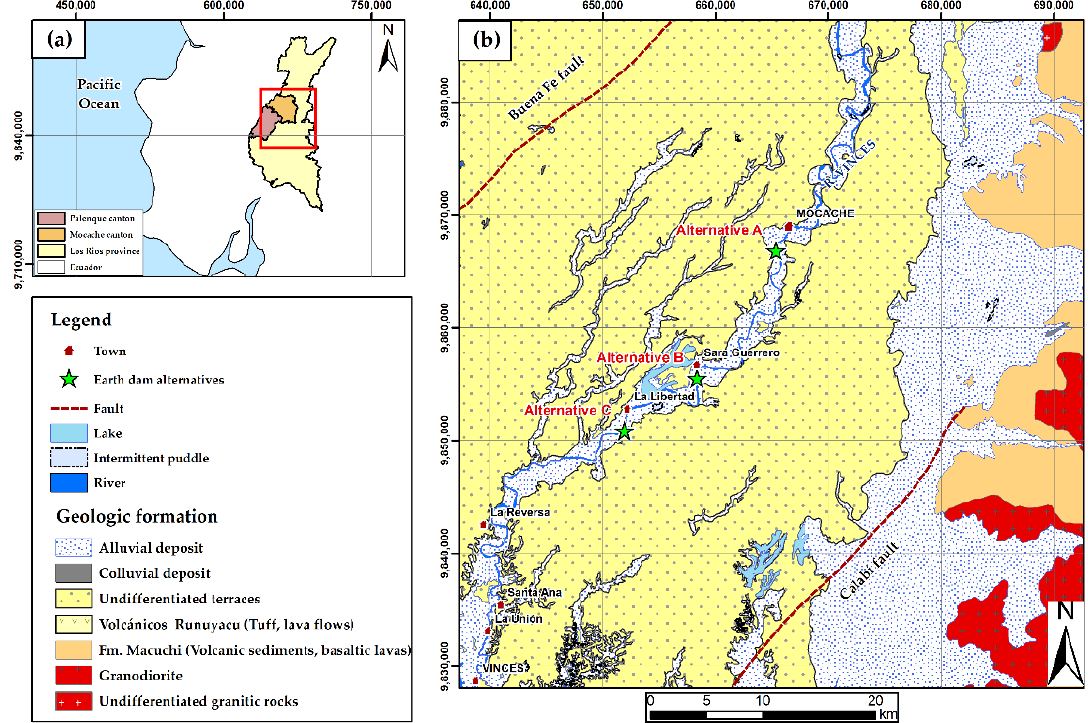
Figure 5. Earth dam alternatives setting. ( a ) Geographic setting in the present study; ( b ) Geological setting with the location of the three alternative locations of the earthen dams [62,63].